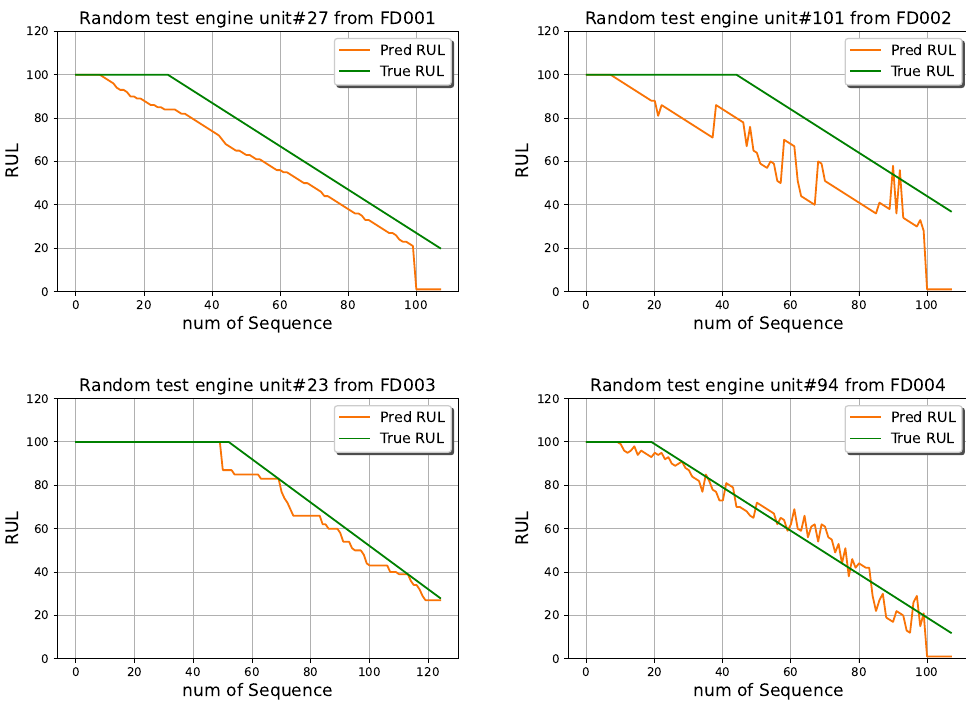
Figure 12. Four example of RUL predictions for the testing engine based on the synchronous FedLSTM